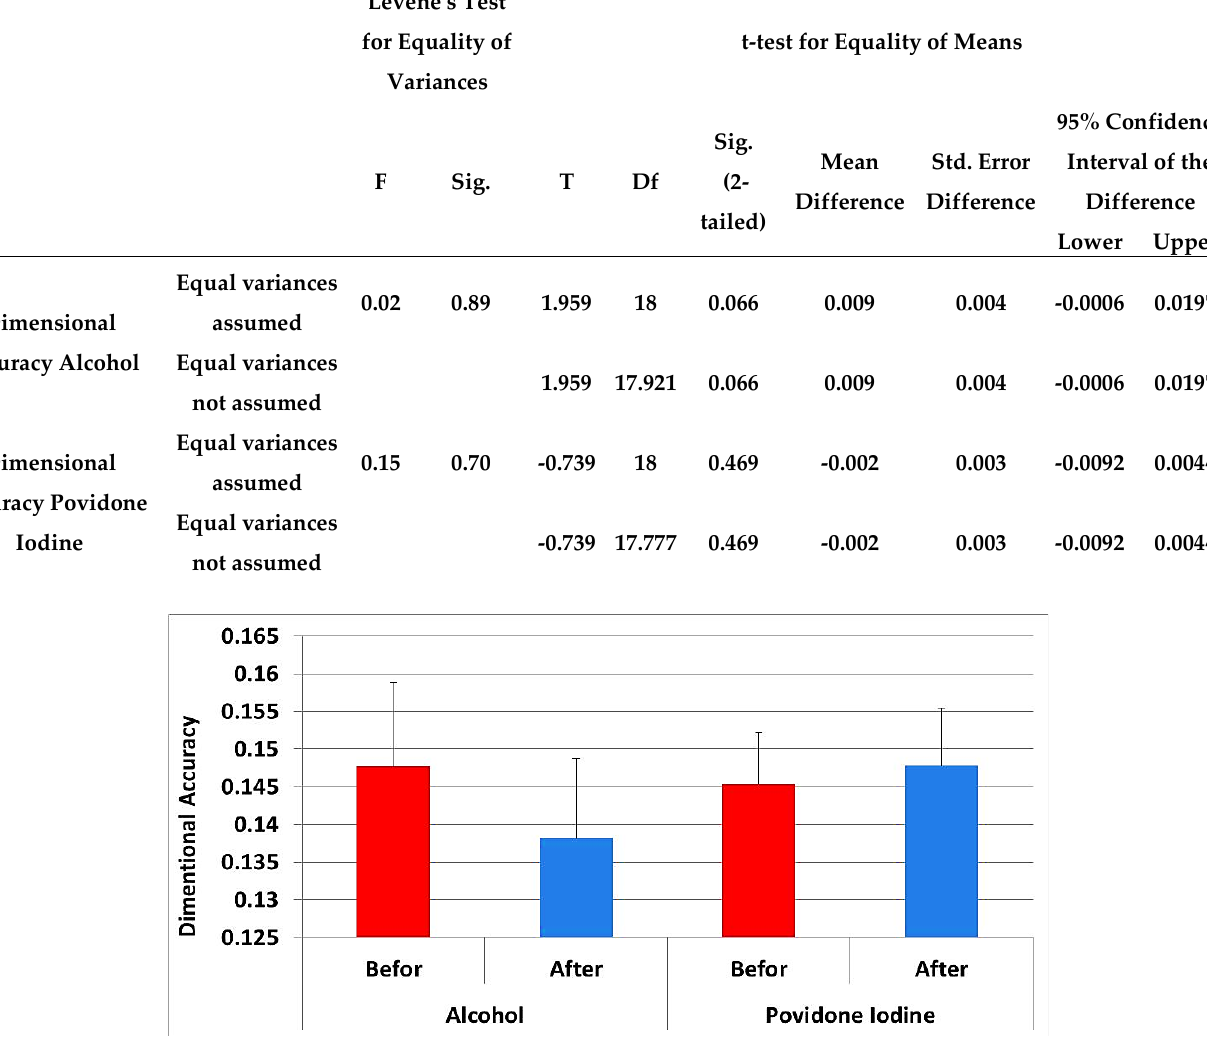
Table (2): F- and T-test of experimental groups